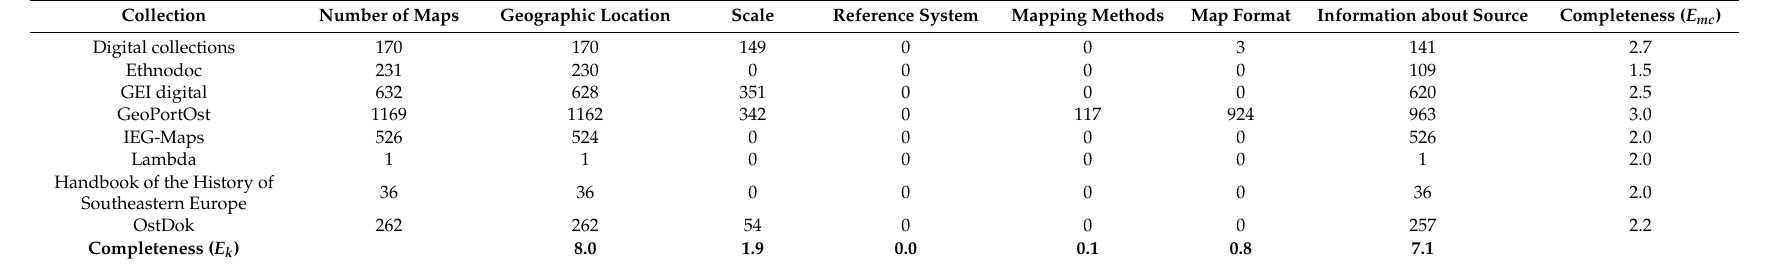
Table 5. Number of objects that have data for cartographic evaluation criteria ( m c